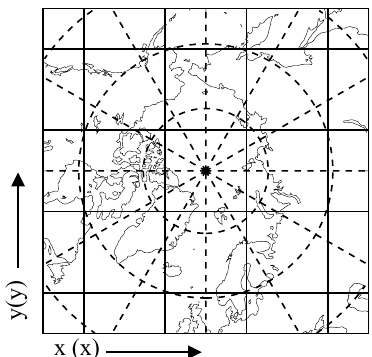
Figure 5. Auxiliary coordinate variables store “alternative” coordi- nates for dimensions. Figure 6. For grid axes based on a map projection, two-dimensional